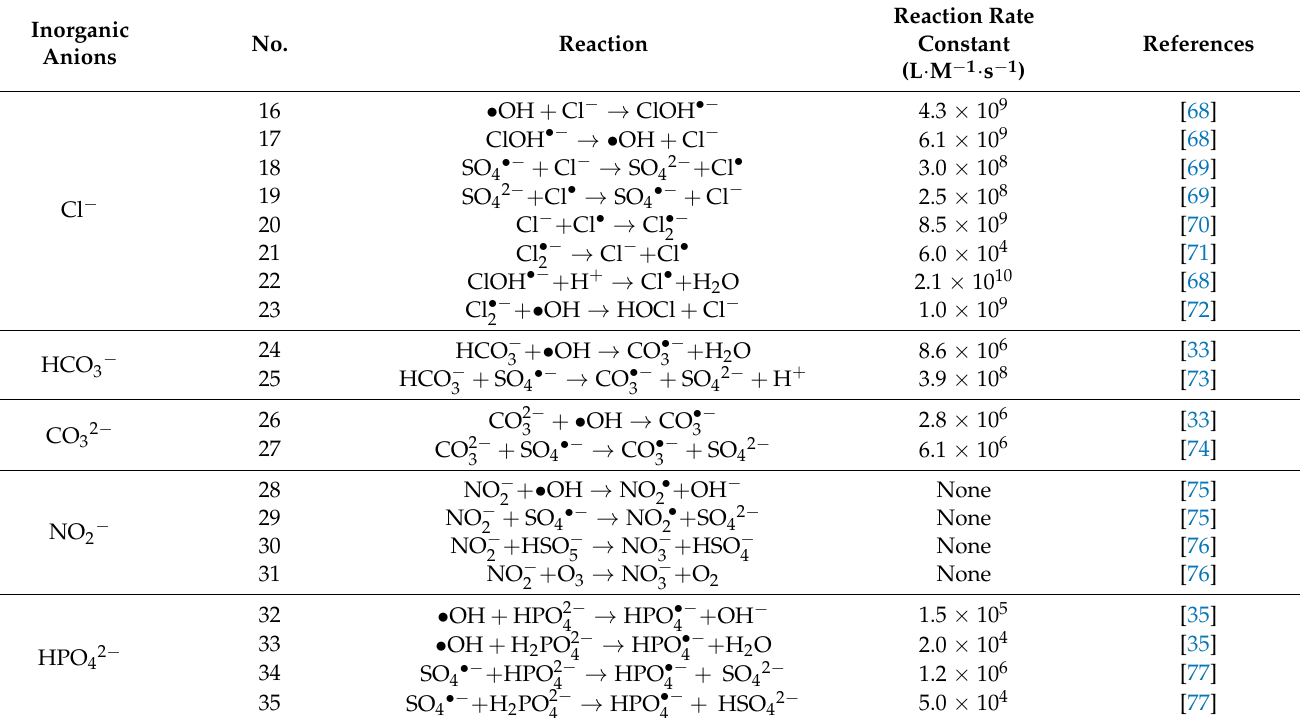
Table 3. The reaction formula of each inorganic ion in the O 3 /PMS system. Inorganic Anions